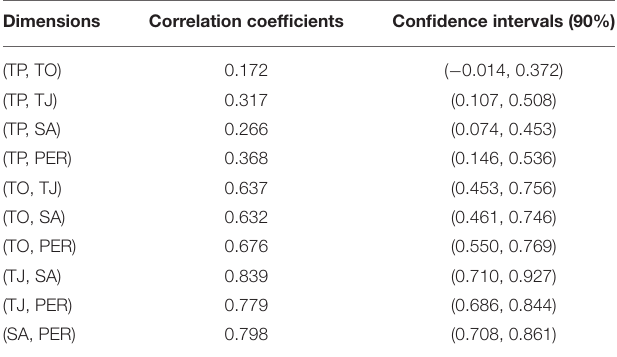
TABLE 6 | Discriminant validity ( N = 81).